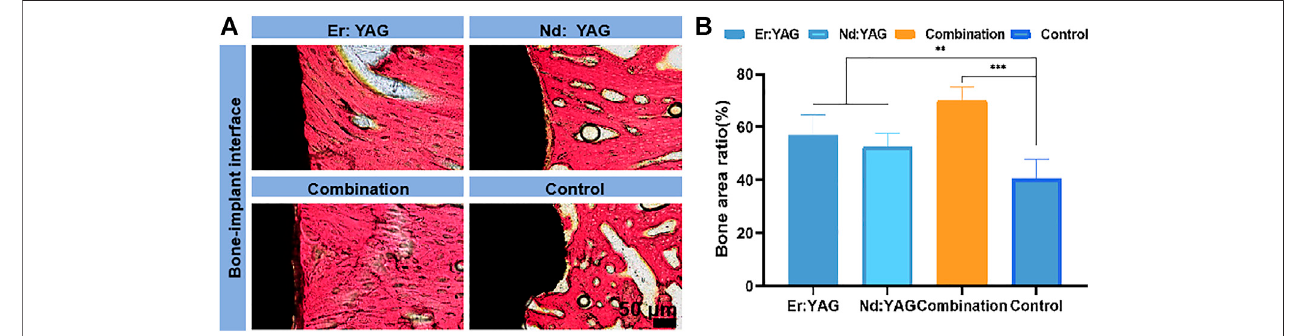
FIGURE 3 | Histological analysis of bone integration. Representative images of (A) van Gieson staining of bone tissue around the implant after 14 days of implantation(blackrepresents thetitanium alloy interface, and red invan Giesonstainingshows collagen fi bers ofthe newbone at theinterfacebetweentheimplant and bone) and proportion of the area of the regenerated bone, following (B) van Gieson staining. ( n = 3, *indicates signi fi cant differences between groups, * p < 0.05; ** p < 0.01; *** p < 0.001).